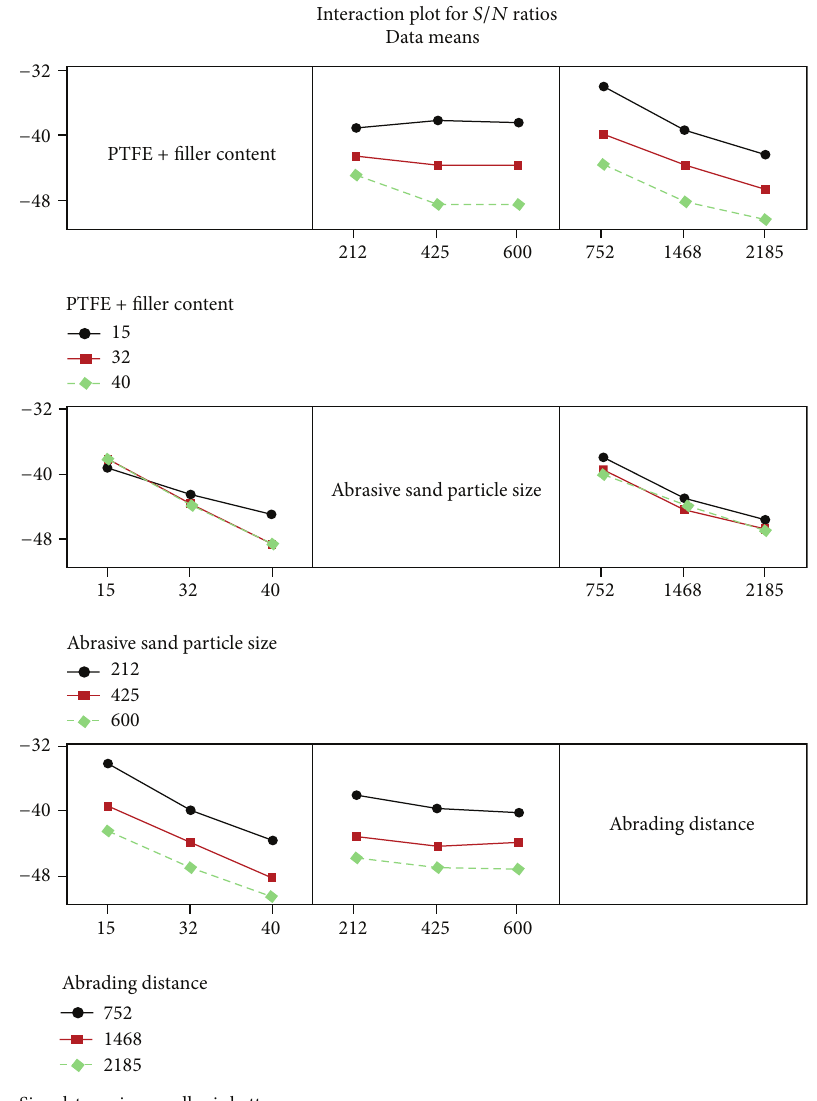
Figure 8: Interaction plot for 𝑆/𝑁 ratio of factors of TCE